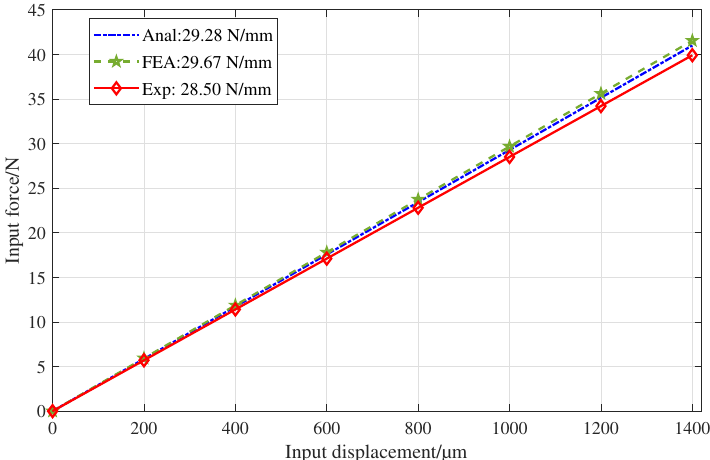
Figure 11. Comparison of input